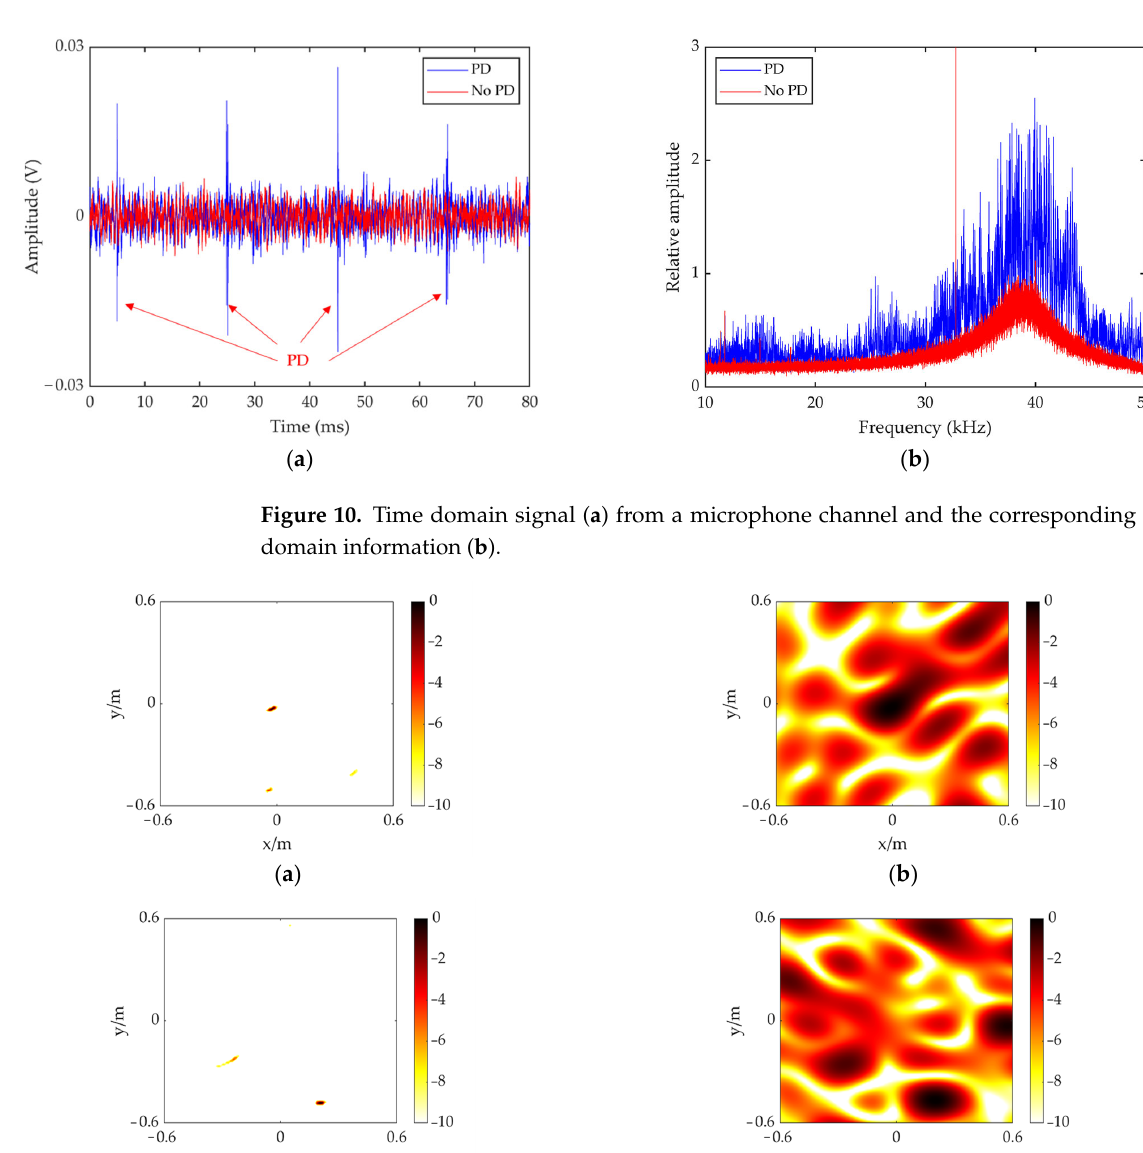
12 of 15 Figure 9. ( a ) The schematic diagram of PD test platform. ( b ) PD experiment site. The distance between two electrodes is 10 mm. The voltage is raised through the high ‐ voltage test console to produce a significant discharge phenomenon. Considering the experimental safety distance and the space limitation of the laboratory, the measure ‐ ment distance is set to 3 m. After connecting the experimental equipment and increasing the voltage, an obvious discharge phenomenon can be observed. The acquired signal from one of the channels is shown in Figure 10. The time and frequency domains reveal distinct discharge features, proving the PD can be effectively detected by our sensor. The size of the calculation plane is set to 1.2 m × 1.2 m. The PD model is located at (0, 0) and (0.20, − 0.45), respectively. The other settings remained the same as in the previous experiment. As shown in Figure 11b,d, the CSIF ‐ based scheme performs poorly, and high ‐ level side ‐